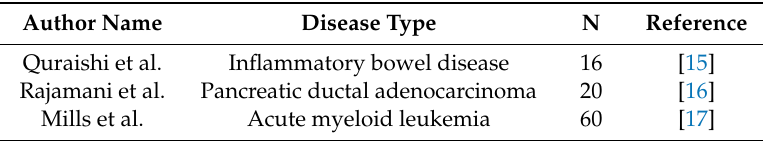
Table 4. Information about all the real-world datasets used in this study. Here, N represents the number of genes used for network